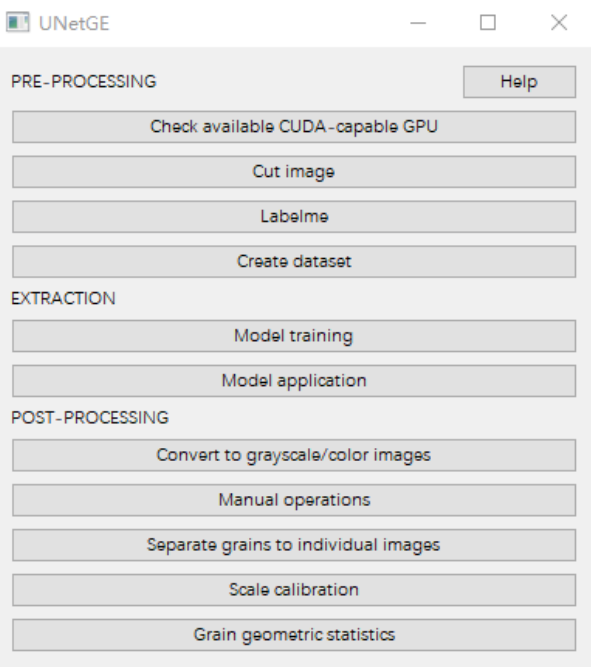
Figure 3. Control panel of